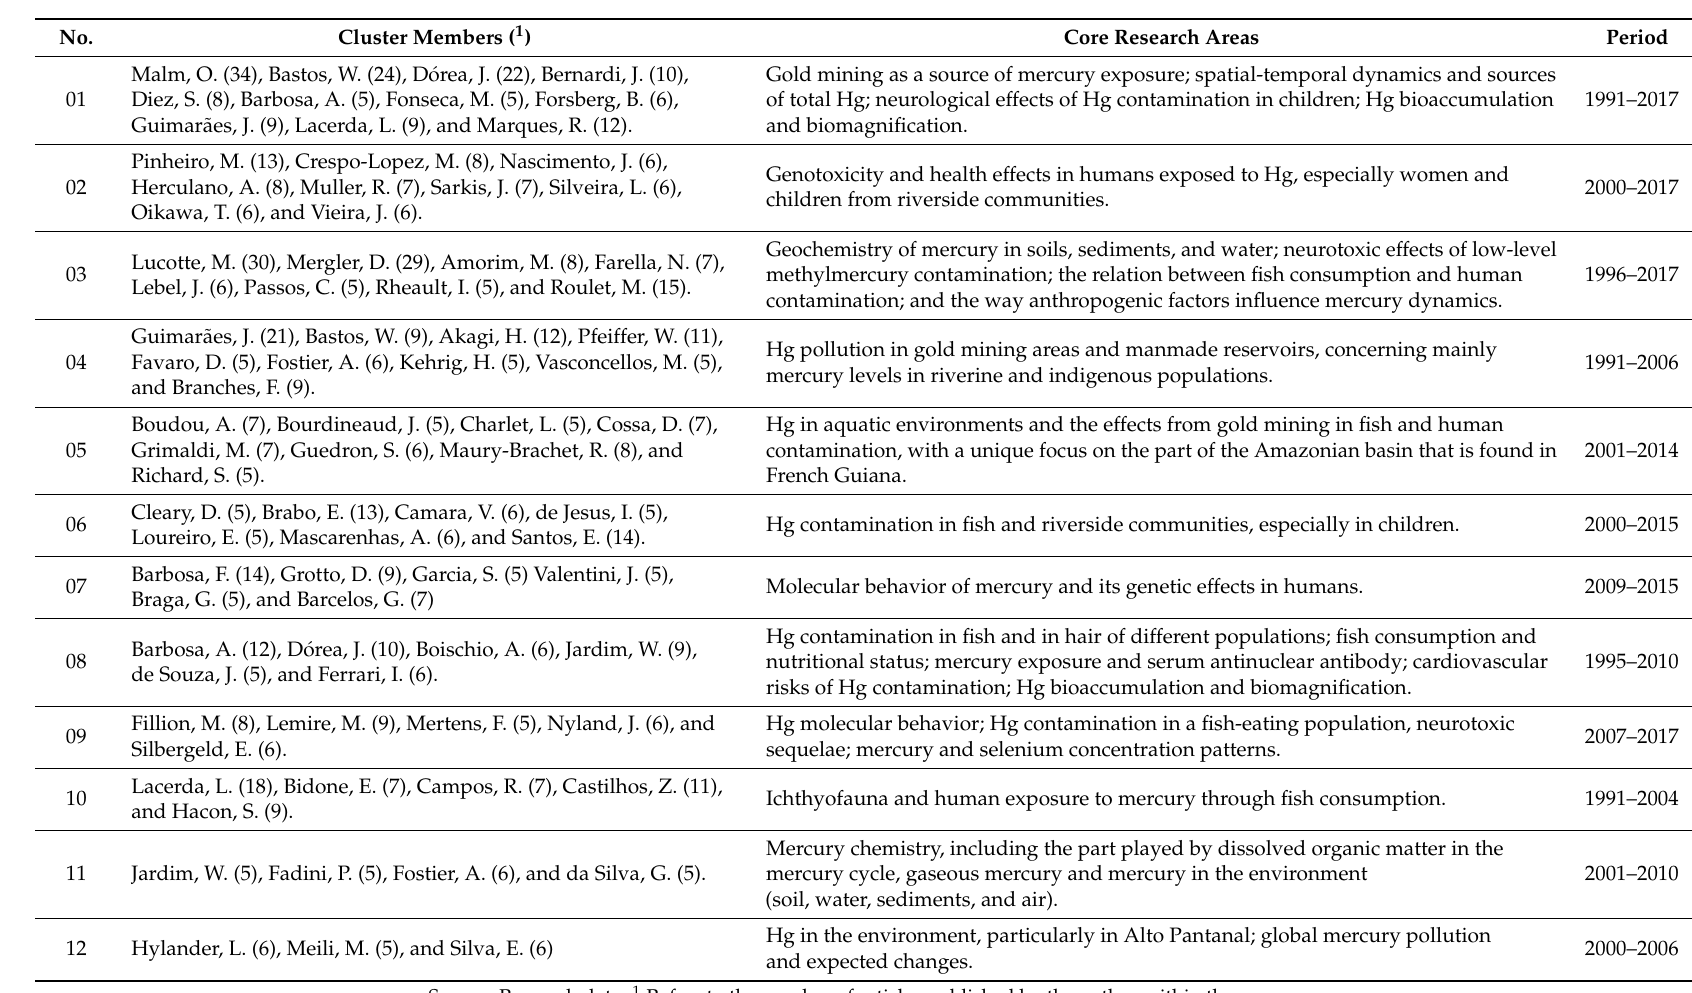
Table 1. Most common authors on Hg in twelve clusters in the Amazon co-authorship network, inferred from 546 publications from 1991 through